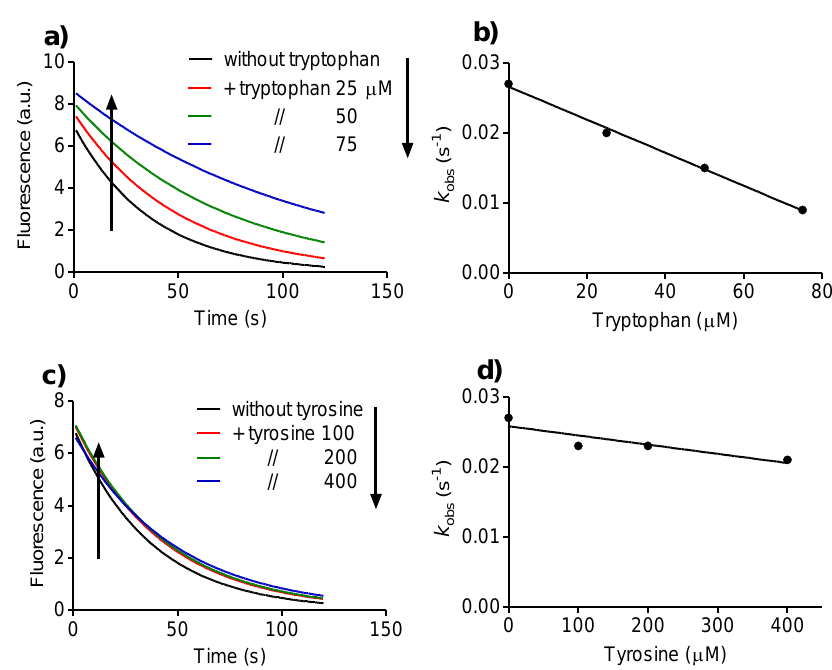
Figure 4. Tryptophan versus tyrosine as targets for Tau-NHBr. ( a ) Reaction of dansylglycine with Tau-NHBr and the effect of tryptophan; ( b ) Effect of tryptophan on the pseudo-first-order reaction rate of dansylglycine with Tau-NHBr; ( c ) Reaction of dansylglycine with Tau-NHBr and the effect of tyrosine; ( d ) Effect of tyrosine on the pseudo-first-order reaction rate of dansylglycine with Tau-NHBr. The reaction mixture was composed of 25 µM dansylglycine, 500 µM Tau-NHBr and increasing concentrations of amino acids in 50 mM phosphate buffer, pH 7.0. The stopped-flow system was set as follows: excitation, 360 nm LED; and emission, 475 nm cut-off filter.